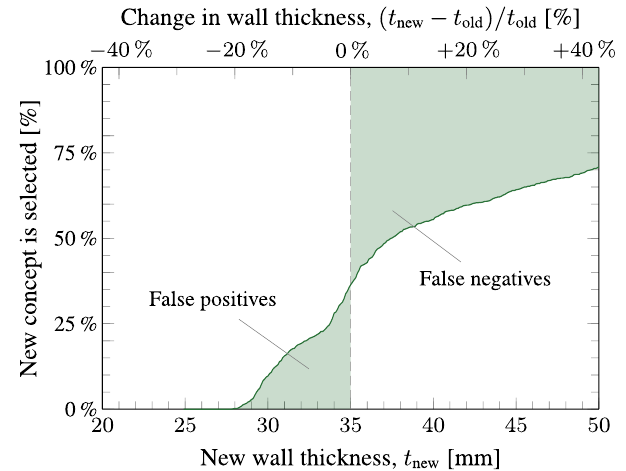
Figure 10. Outcome of a concept selection, where a new wall thick- ness is either accepted or rejected on the basis of a 50-year stress level using an aggregation-before-fitting approach with a GEV fit- ted above a threshold with a sample size of N = 10 3 .